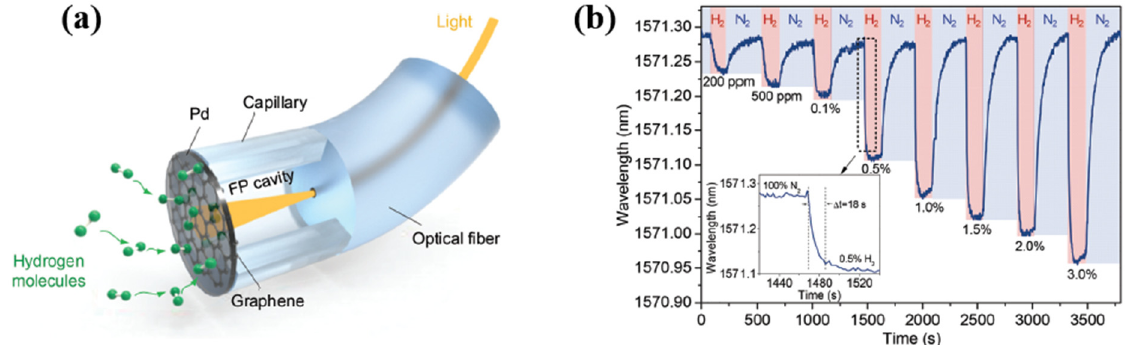
Figure 39. ( a ) Schematic of a fibre-optic H 2 -sensor with Pd-decorated MLG film, and ( b ) temporal response of the Pd/MLG sensor with a 5.6 nm Pd film for various H 2 concentrations [163]. Copyright (2019), with permission from Royal Society of Chemistry.